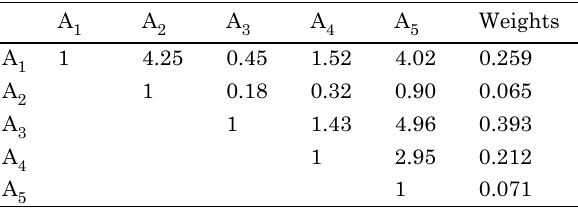
Table 6. Pairwise comparison judgment matrix of each type of exterior walls in the index of performance cost